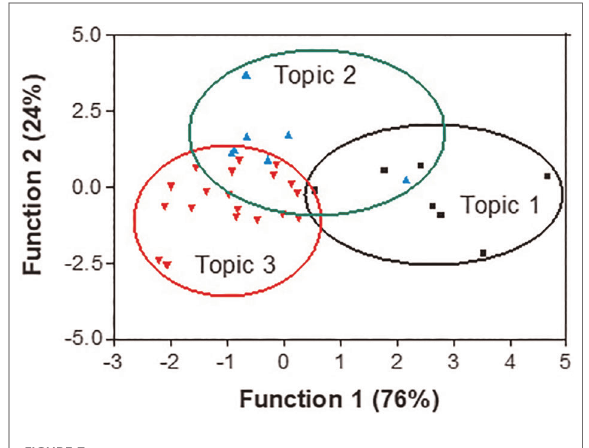
FIGURE 7 Canonical discriminant analysis plot for the three